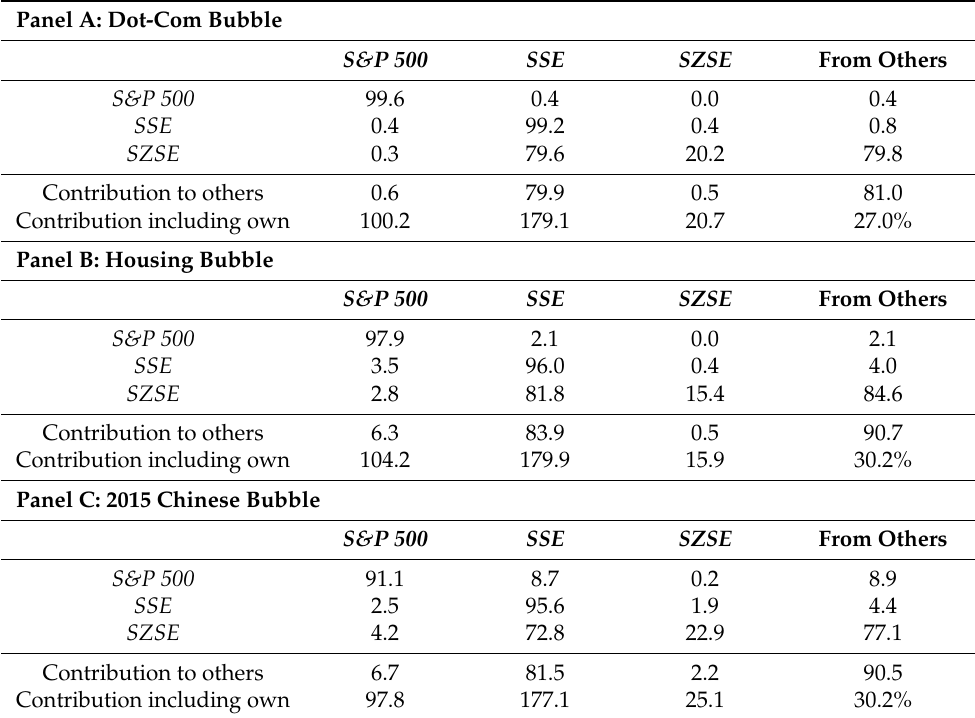
Table 6. Volatility Spillover